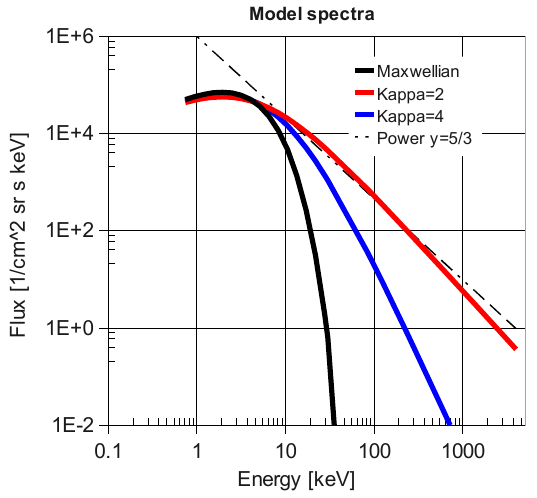
Fig. 2. Functional forms of different spectra used to describe a par- ticle population. The κ distribution is essentially a Maxwellian for low energies combined with a power law spectra for higher ener- gies.